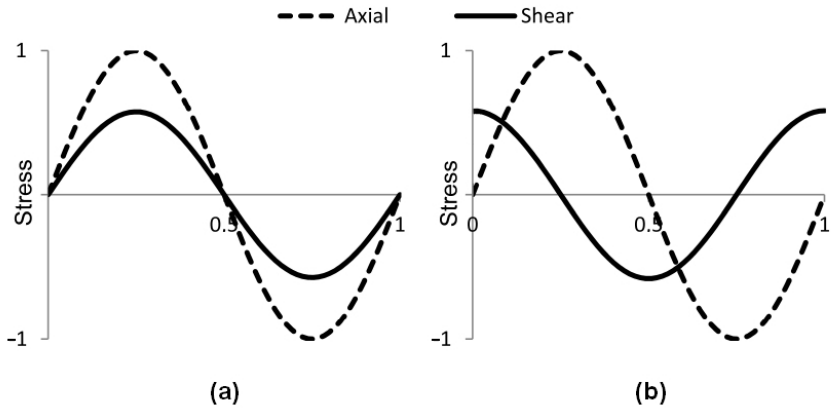
Figure 2. ( a ) Proportional loading time variation, and ( b ) non-Proportional loading time variation.